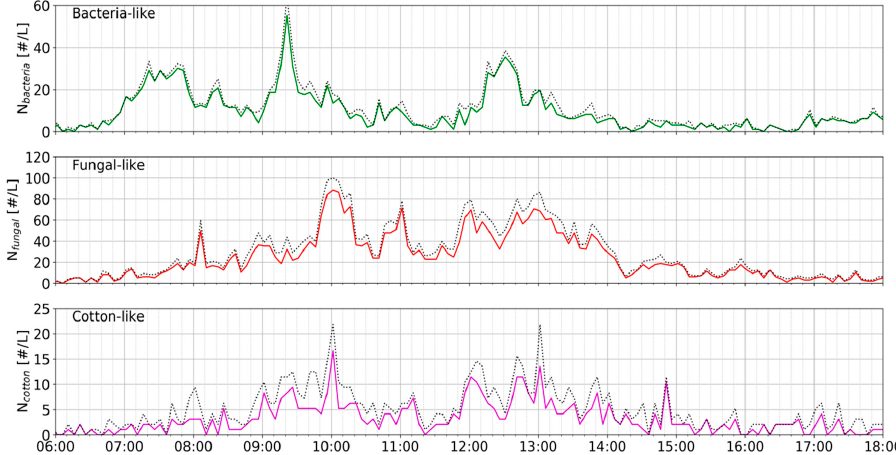
Figure 8. Same as Figure 7, but for the period 06:00–18:00 on Friday the 13th of March 2020.